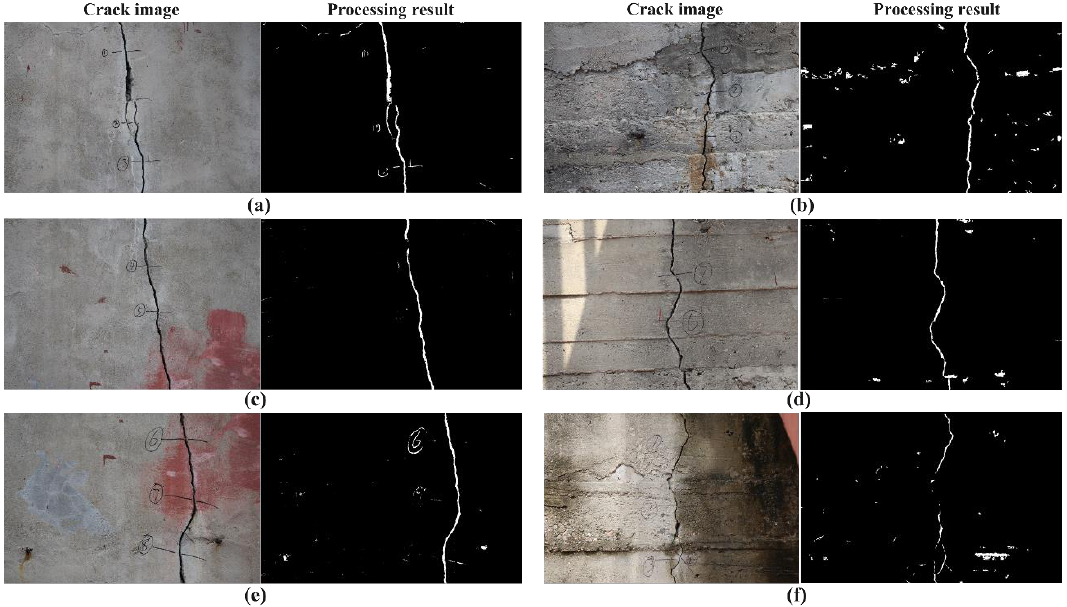
Figure 26. Original image of the captured crack and the processed result. ( a ) crack No.1 to No.3 on simple background, ( b ) crack with lots of noises, ( c ) crack No.4 and No.5 on simple background, ( d ) crack on uneven plane, ( e ) crack No.6 to No.8 on simple background, ( f ) crack on complex background.